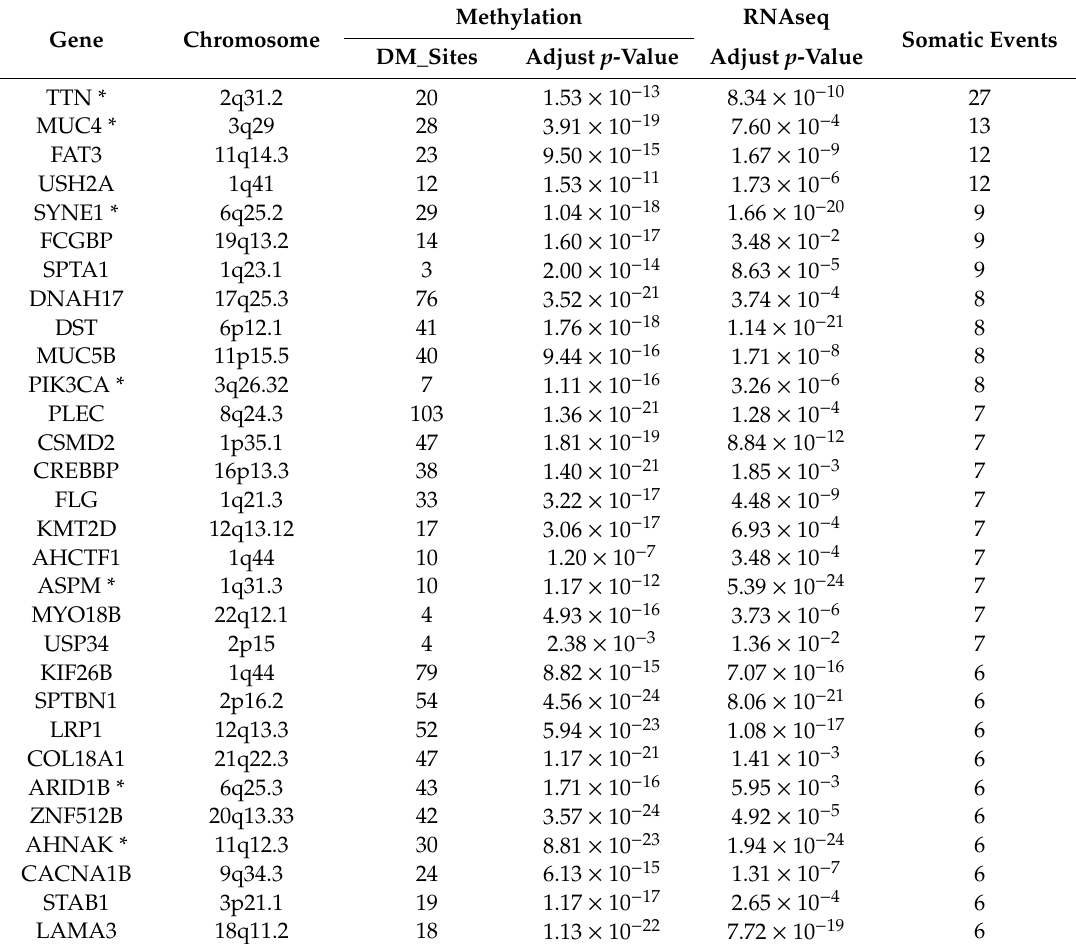
Table 3. List of the top 30 genes containing both somatic and epigenetic alterations transcriptionally associated with TNBC. DM represents di ff erentially